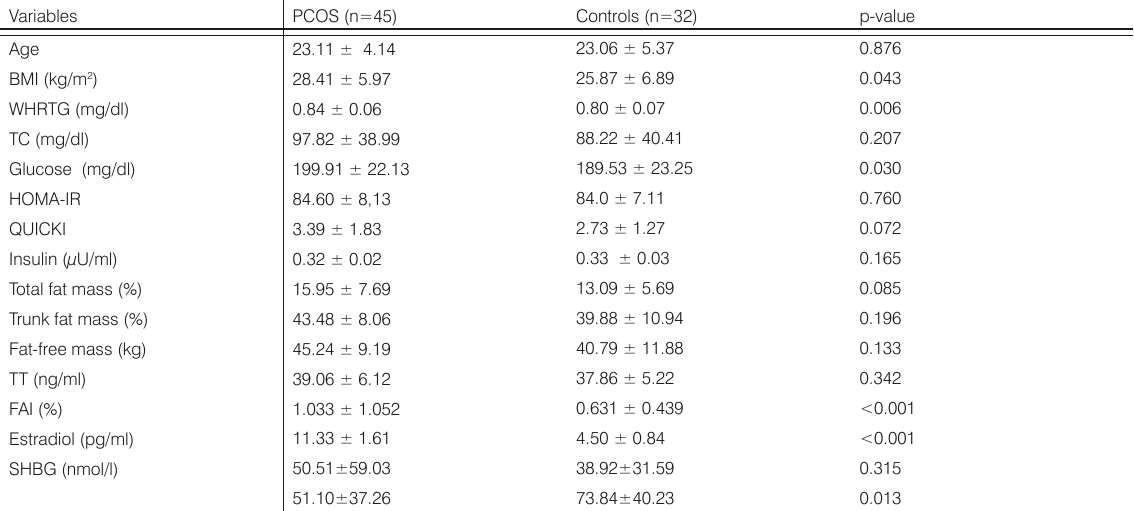
Table 1. Anthropometric, hormonal and metabolic profile in PCOS and control women. Data are given as mean ± SE; p<0.05 was considered statistically significant.